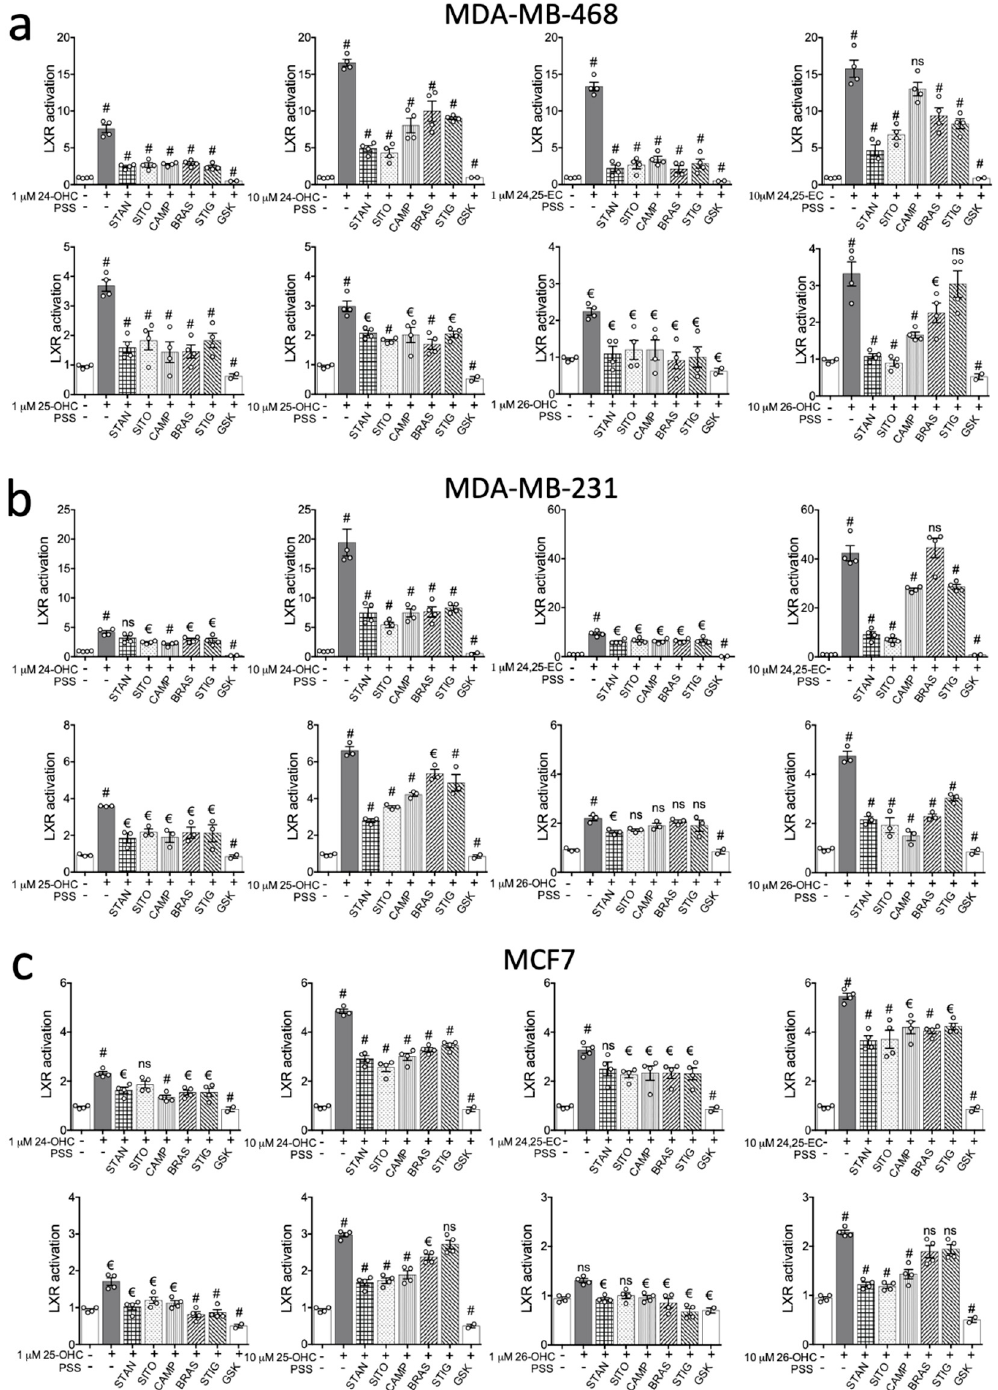
Figure 4. Phytosterols inhibit oxysterol driven LXR activation in breast cancer cells. Oxysterol-mediated LXR activity was measured in the presence of PSSs or synthetic LXR antagonist GSK2033. ( a ) MDA-MB-468 ( b ), MDA-MB-231 ( c ) and MCF7 LXR-luciferase reporter cell lines were